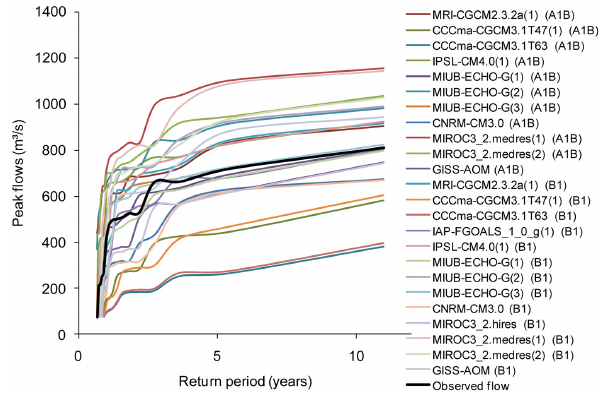
Fig. 10. Return period of daily peak flow extremes for Lake Tana catchment, for future period (2046–2065) (VHM